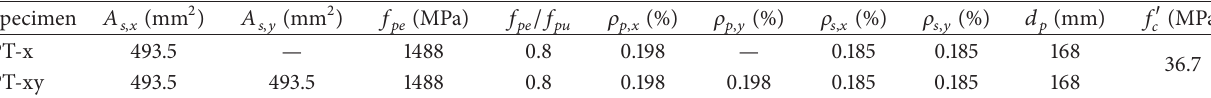
Figure 5: Details of the specimens. Table 1: Details of